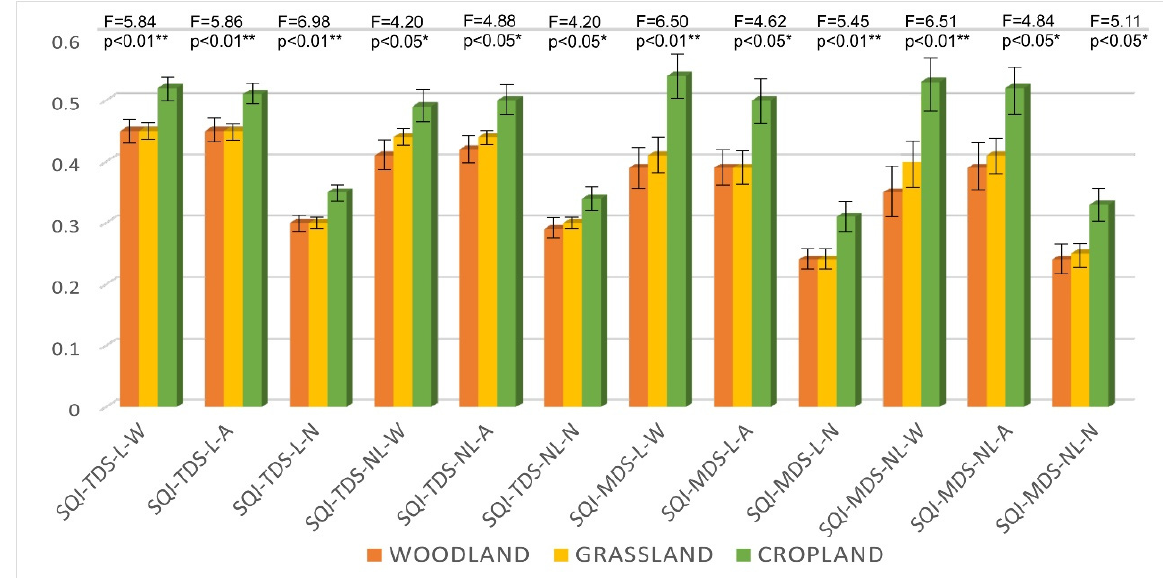
Figure 8. Comparison of the soil quality indices developed in this study in different land uses. The bars represent the standard deviation. The F and p values were the results of the ANOVA test.